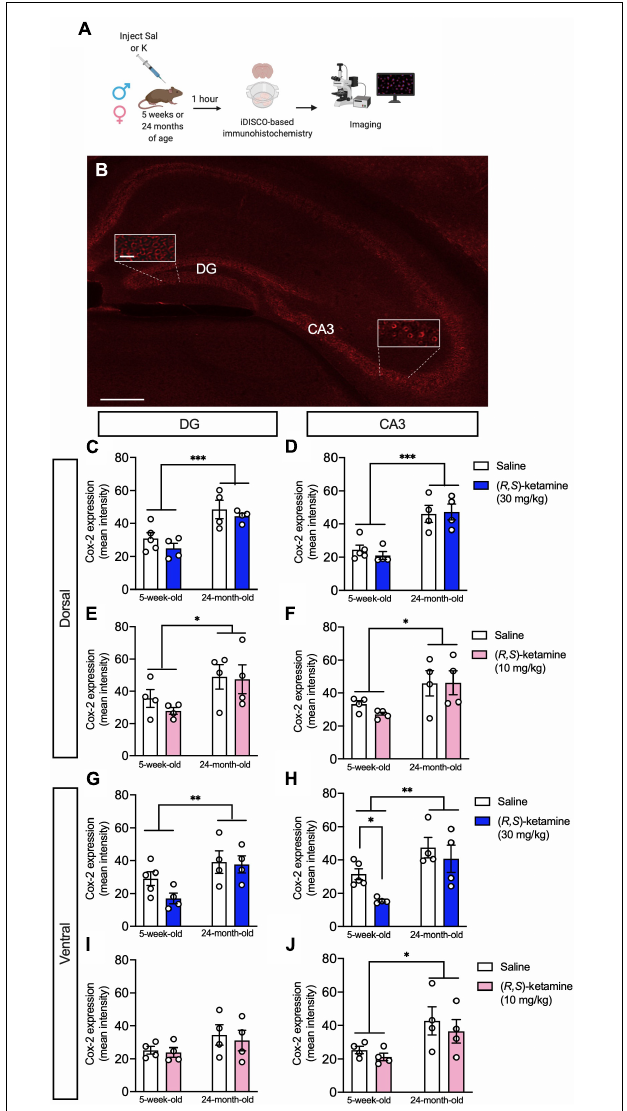
FIGURE 4 | ( R,S )-ketamine selectively decreases Cox-2 expression in ventral CA3 of adolescent male mice. (A) Experimental design. (B) Cox-2 expression in the hippocampus. Scale bar: 250 and 25 µ m (inset). (C,D) Twenty-four-month-old male mice had increased Cox-2 expression in the dorsal DG and dorsal CA3 when compared with 5-week-old mice. ( R , S )-ketamine did not impact Cox-2 expression. (E,F) Twenty-four-month-old female mice had increased Cox-2 expression in the dorsal DG and dorsal CA3 when compared with 5-week-old mice. ( R , S )-ketamine did not impact Cox-2 expression in either region. (G,H) Twenty-four-month-old male mice had increased Cox-2 expression in the ventral DG and ventral CA3 when compared with 5-week-old mice. ( R , S )-ketamine did not impact Cox-2 expression in the ventral DG. However, in 5-week-old male mice, ( R,S )-ketamine decreased Cox-2 expression in ventral CA3. (I) All groups of female mice showed similar level of Cox-2 expression in the ventral DG. ( R , S )-ketamine did not impact Cox-2 expression. (J) Twenty-four-month-old female mice had increased Cox-2 expression in vCA3 when compared to 5-week-old mice. ( R , S )-ketamine did not impact Cox-2 expression. Error bars represent + SEM. ∗ p < 0.05, ∗∗ p < 0.01, ∗∗∗ p < 0.001. Sal, saline; K, ( R , S )-ketamine; DG, dentate gyrus; CA3, Cornu Ammonis region 3; iDISCO, immunolabeling-enabled three-dimensional imaging of solvent-cleared